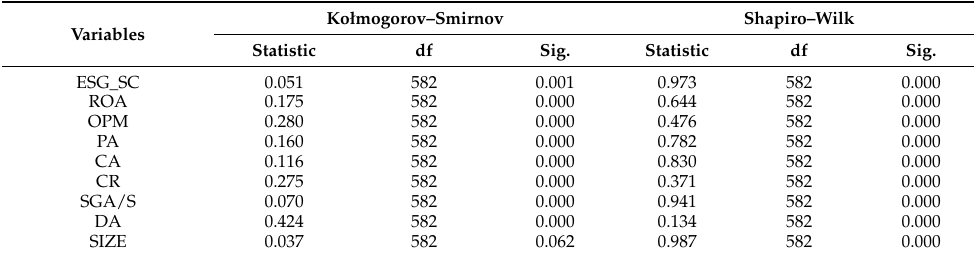
Table A1. Tests of normality distribution.